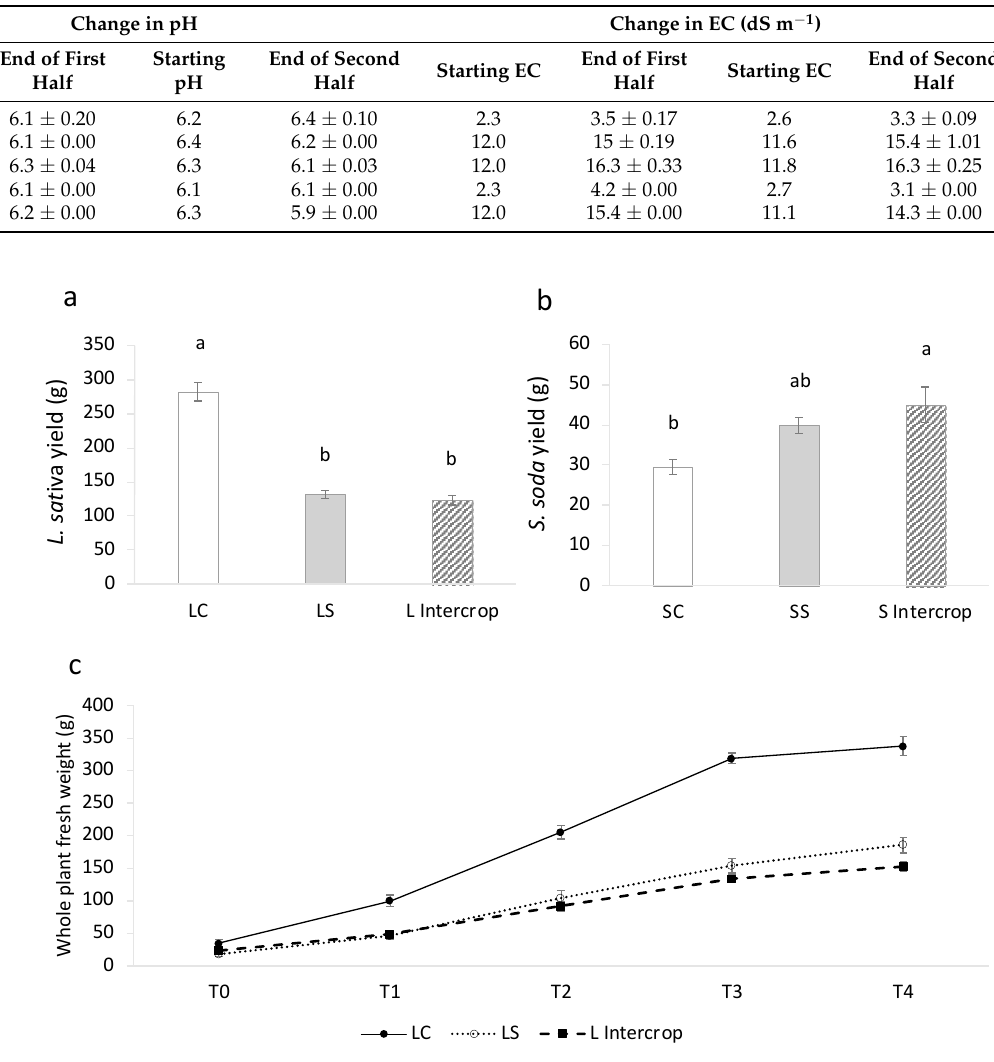
Table 1. Changes in solution pH and electrical conductivity (EC) over the 4-week trial with a complete replacement of the solutions at 2 weeks. Values are means ± SEM.